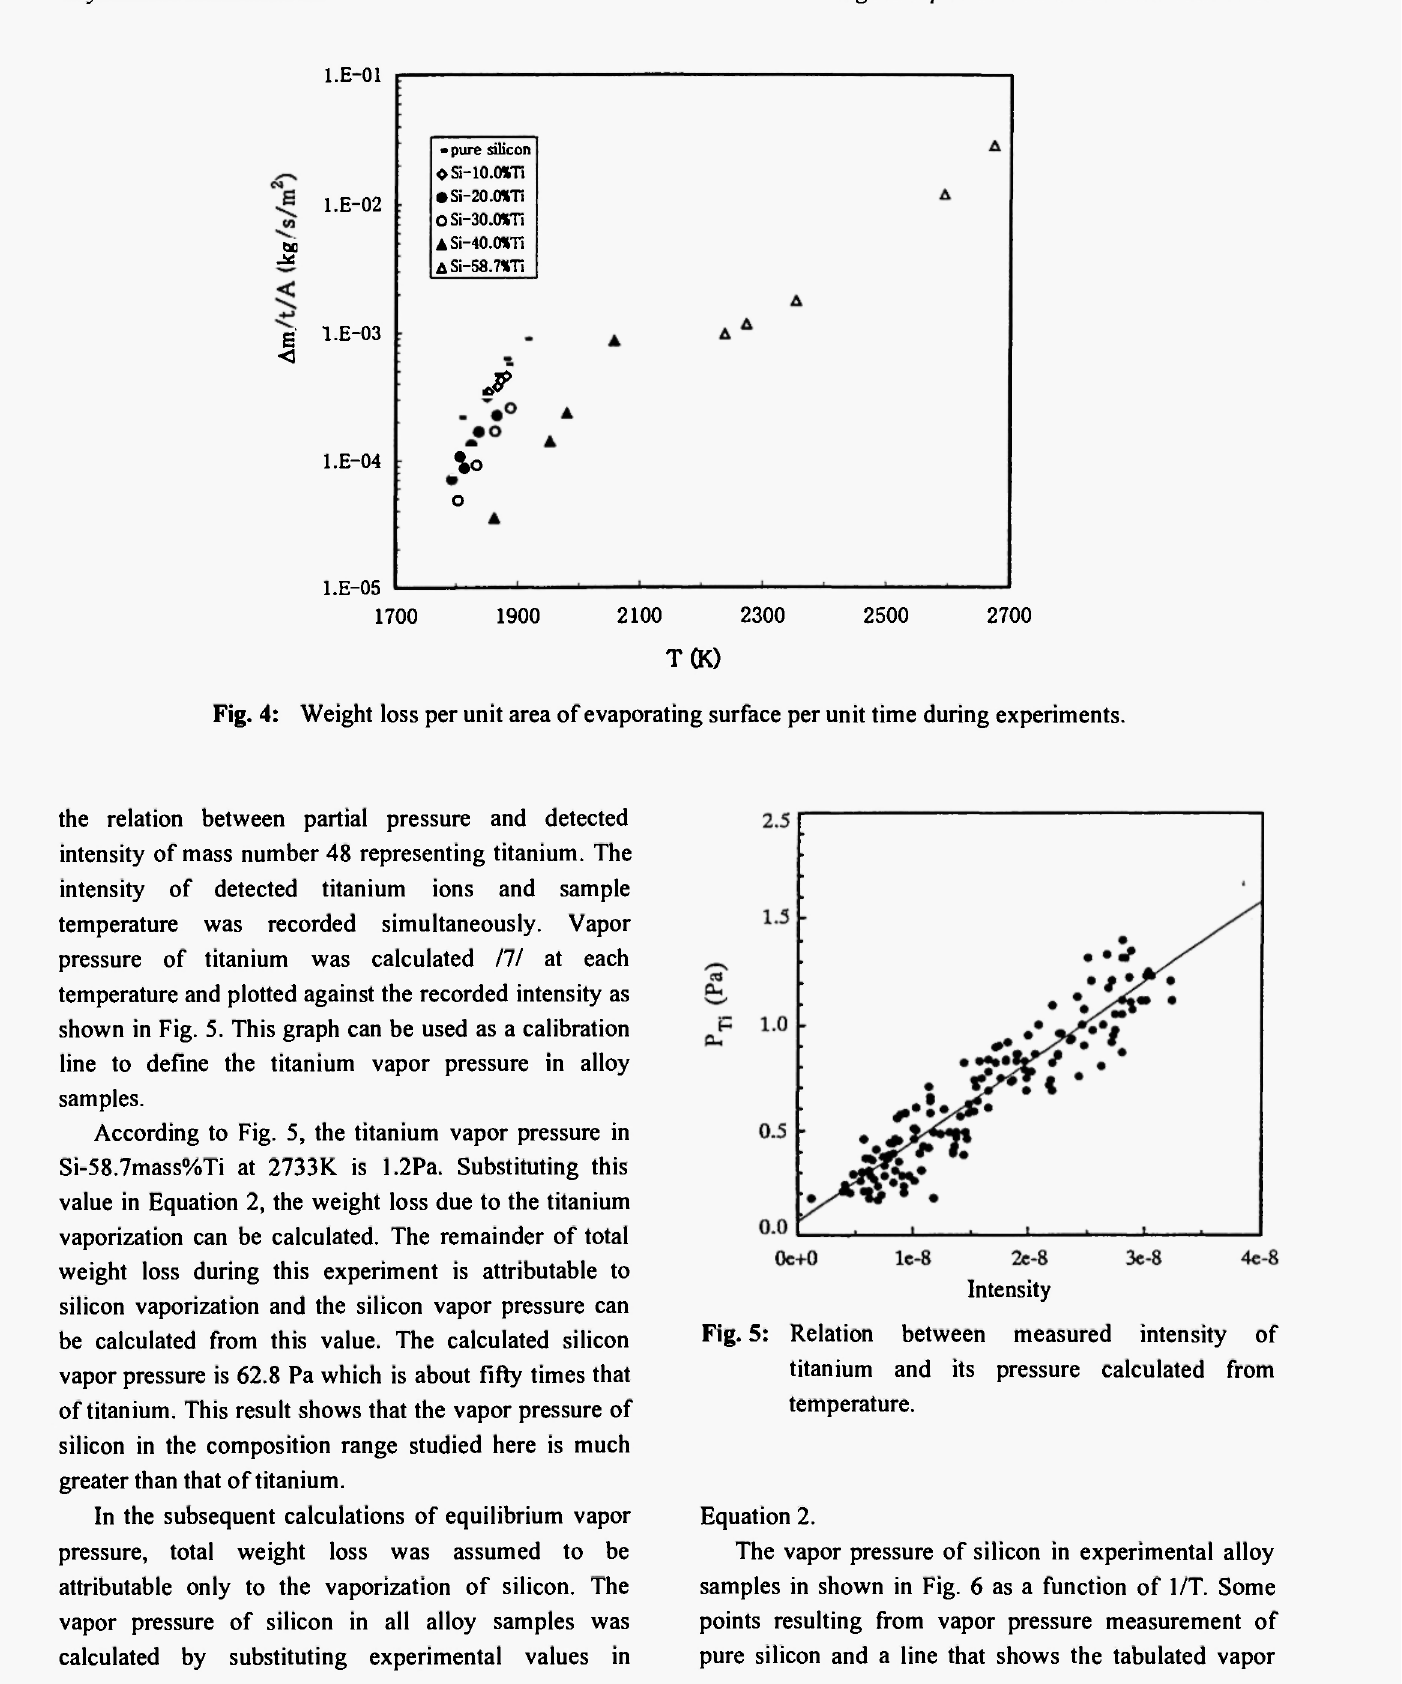
Intensity Fig. 5: Relation between measured intensity of titanium and its pressure calculated from temperature.